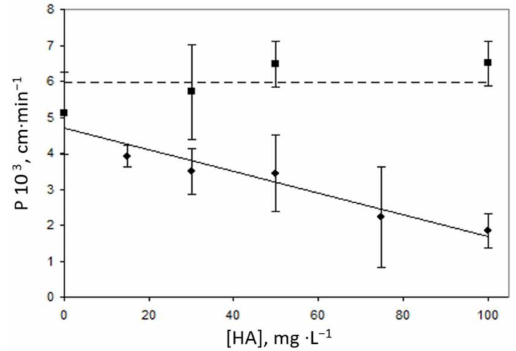
Figure 5. Effect of HA concentration on the permeability coefficient. ( ) sample without treatment; ( (cid:4) ) sample after UV treatment for elimination of organic matter (dashed line indicates average